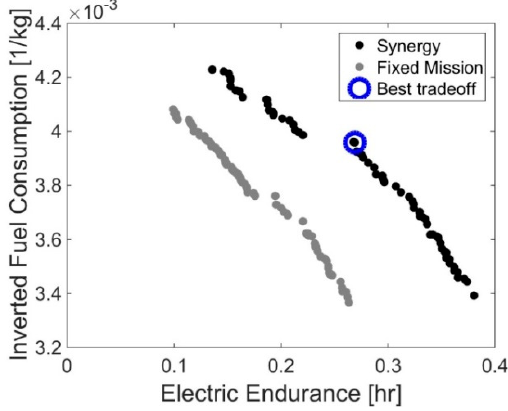
Figure 12. Results of the MALE-UAV optimization problem.